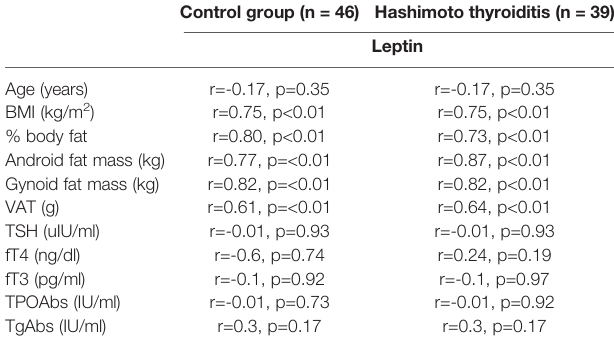
TABLE 2 | The relationship between clinical, biochemical, and hormonal parameters and serum AMH concentration in Hashimoto thyroiditis patients and the control group.